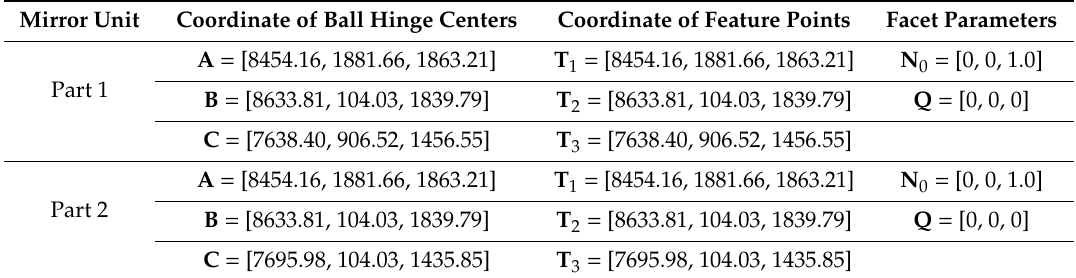
Table 1. Coordinates of the ball-hinge centers, feature points and facet parameters of Part 1 and Part 2. Mirror